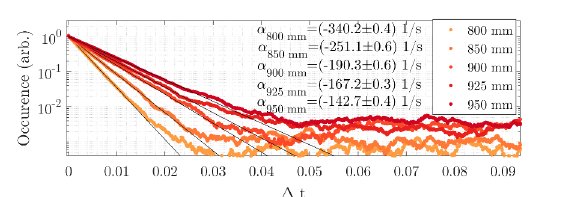
Figure 1: Analog T4 + FREYA (n,f) time stamp Rossi distributions and fits for single exponent models for different water levels of